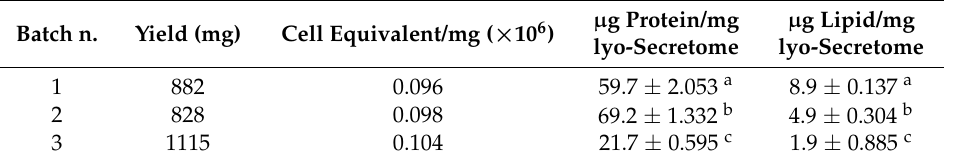
Table 2. Lyo-secretome total protein and lipid content; mean values ± standard deviation, n = 3. Different letters indicate a significant difference between groups ( p < 0.0001).